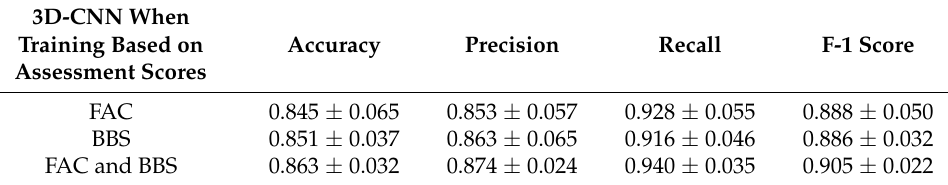
Table 2. The detection scores (accuracy, recall, precision, and F-1 score) of dependence in ambulation using a trained 3D-CNN model.